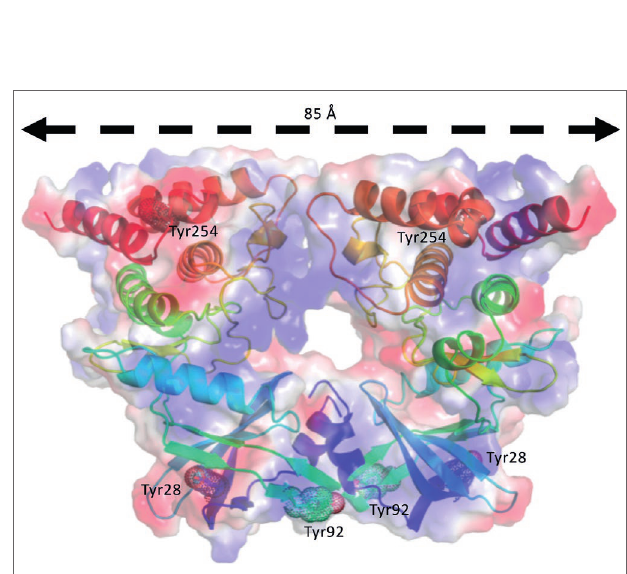
FIGURE 8 | Model of a face-to-face YabT( ∆ TM) dimer. The model was built by superimposition of the structure of YabT( ∆ TM) on both subunits of the face-to-face dimer of PknB (PDB ID 3F69). The electrostatic surface of the dimer is shown in transparency with negatively and positively charged region colored in red and blue, respectively. Each polypeptide chain is shown as a cartoon trace colored in a rainbow scheme from blue to red. Tyrosine residues phosphorylated by the BY-kinase PtkA are highlighted by dots and